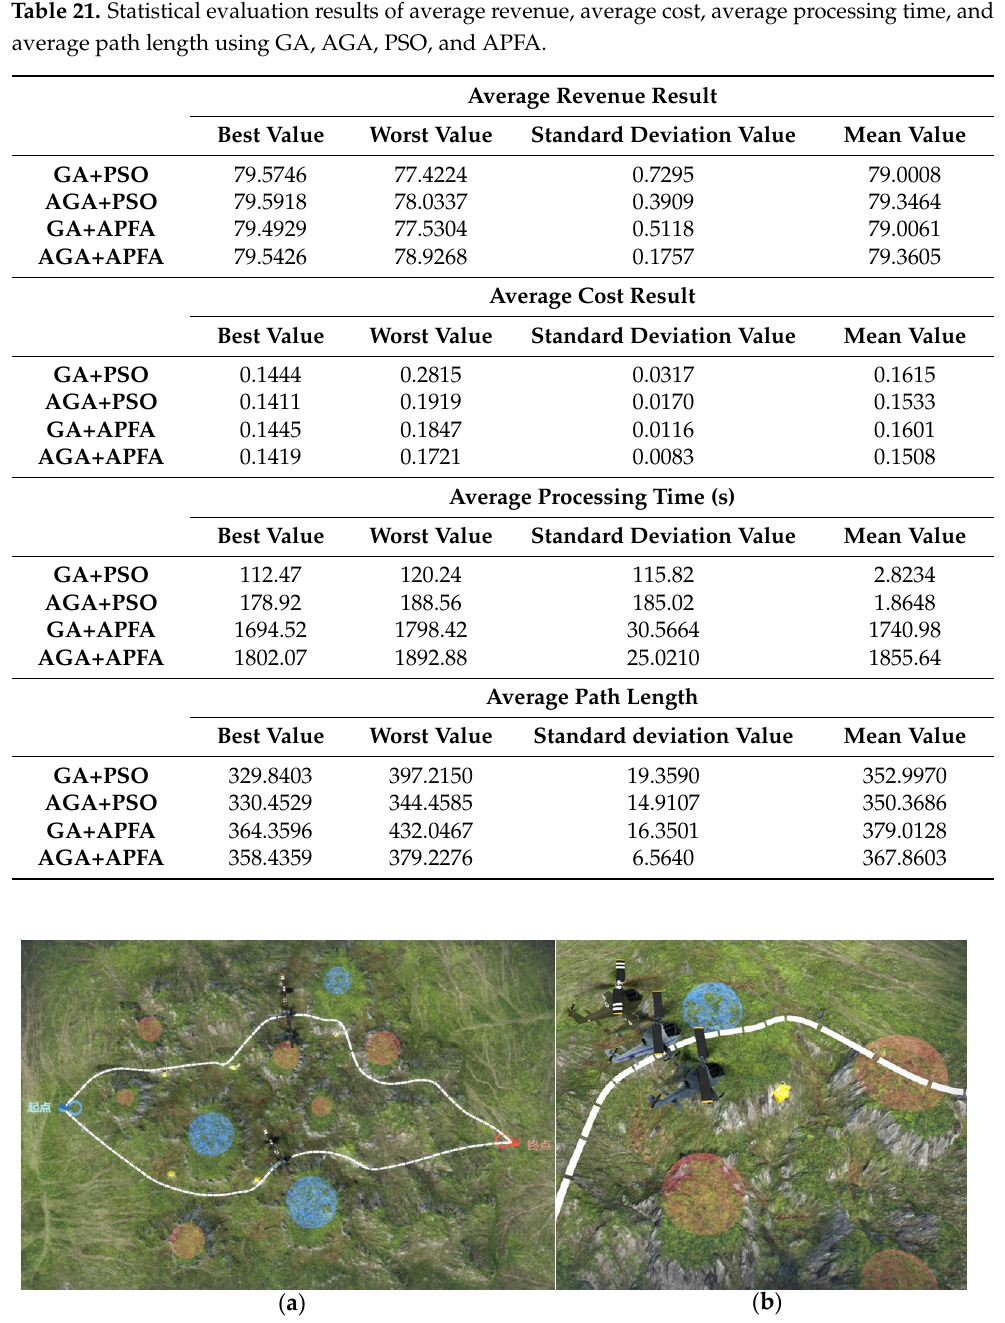
Figure 14. Visualization simulation examples of proposed method. ( a ) Global field view of simulation result. ( b ) Local field view of simulation result.